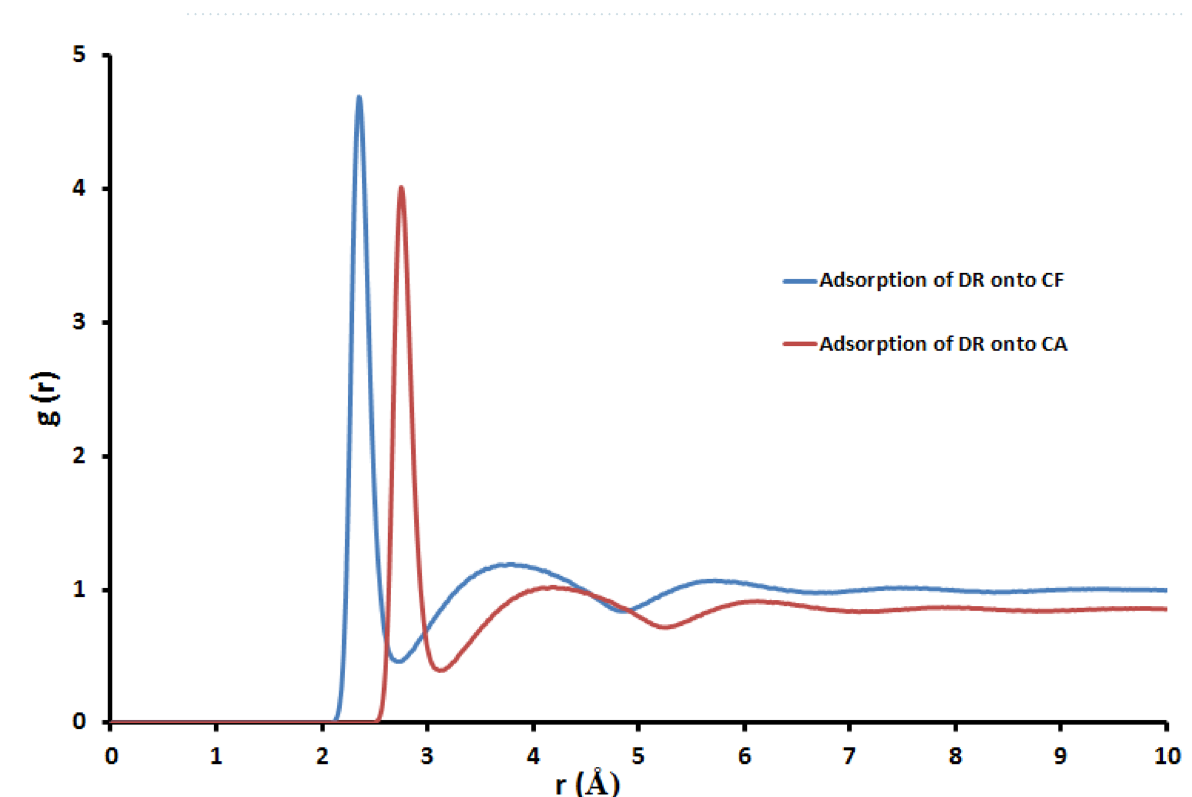
Figure 19. The RDFs for the interaction sites of DR molecule on CA and CF surface atoms in the presence of water at 10